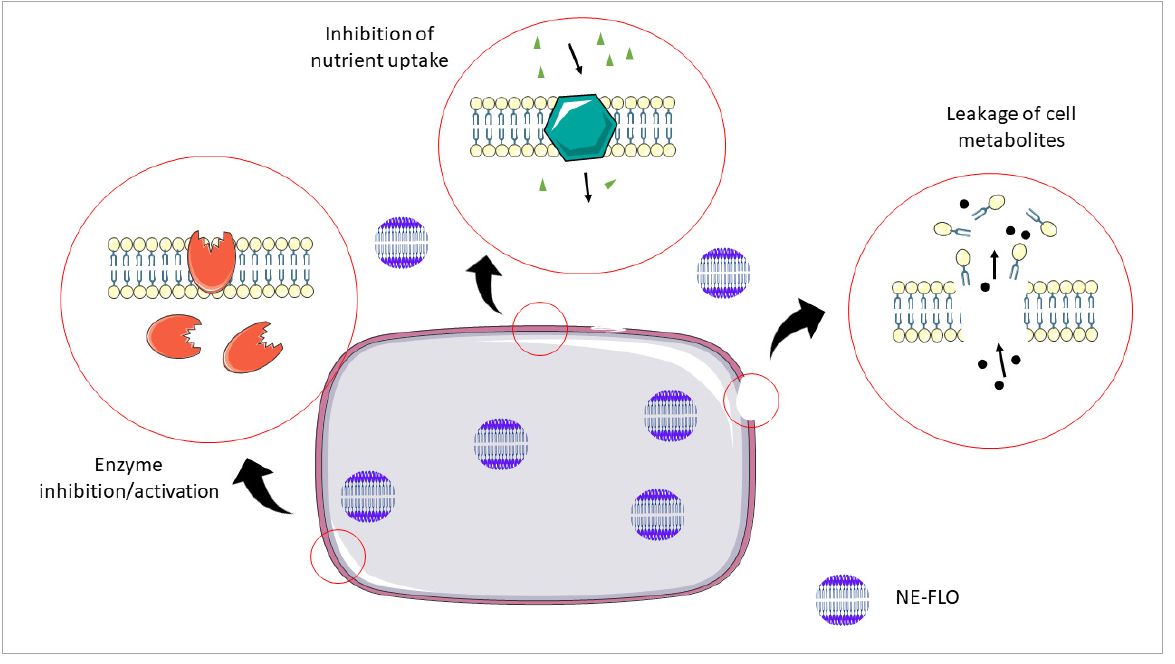
Figure 5. Possible mechanism of antibacterial activity of NE-FLO.